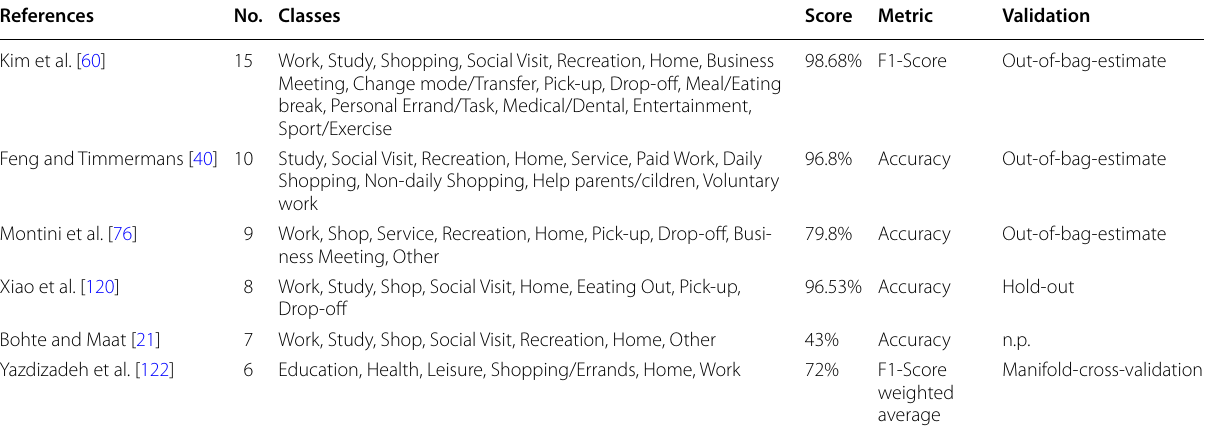
Table 4 Classification task ranked by difficulty and score, for purpose